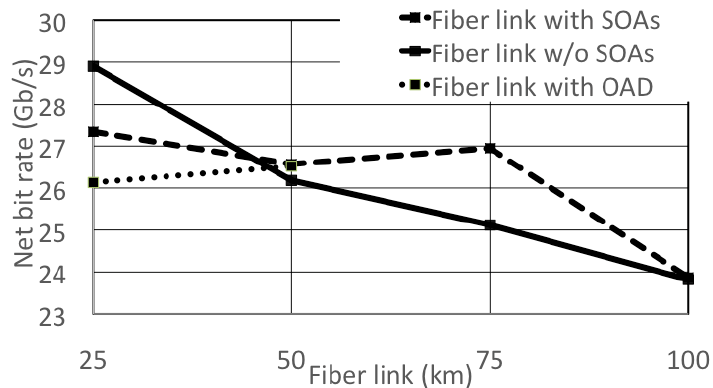
Figure 7. Net bit rate versus fiber link (with and without SOAs and including SOA-based OAD nodes), using RA BL/PL algorithm, for an OSNR of 33 dB at a target BER of 3.8 × 10 −3 .